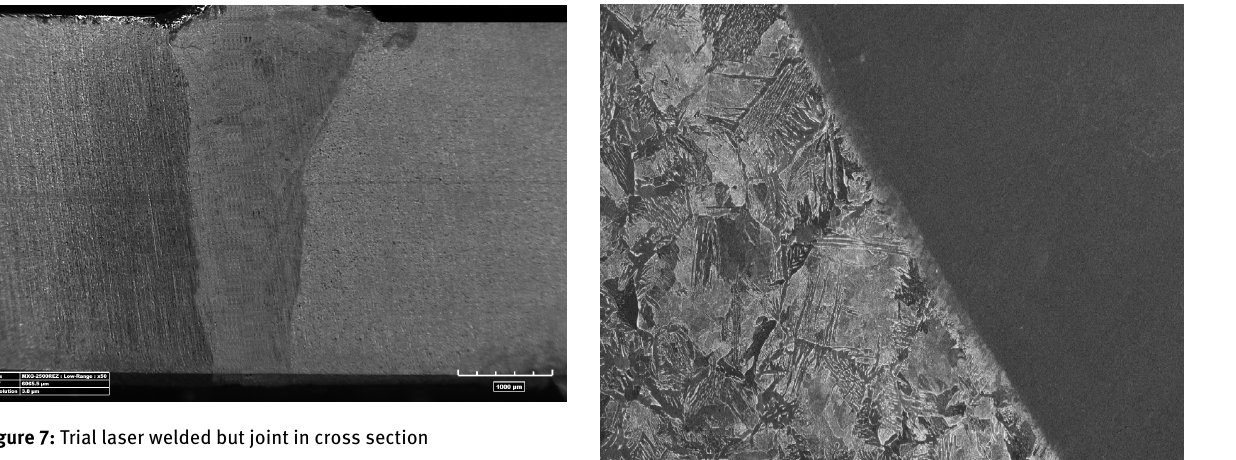
Structure of base material for 316L was austenitic and forS235JRwas ferritic-pearlitic. Microstructureofobtained weld was assumed as a dendritic and are related to crystal- lization direction. Heat affected zone shown differences in structure over base materials. In austenitic steel grain re- fining (Figure 8) and in low carbon steel grain growth (Fig- ure 9) was observed [28].